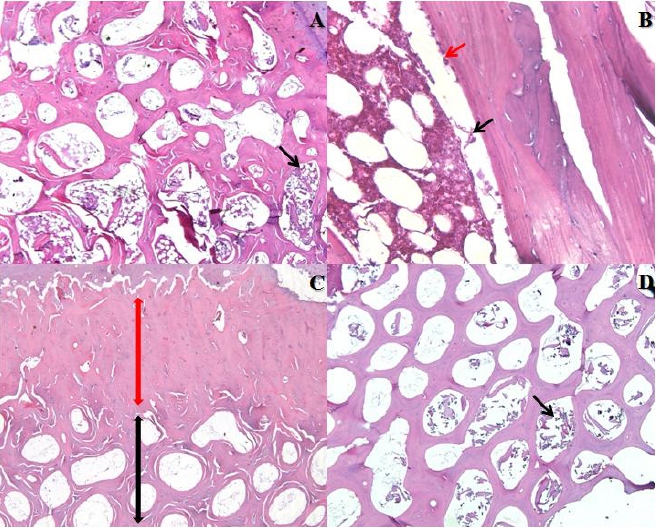
FIGURE 5 – Photomicrographies of the femoral head of ovines submitted to induction of osteonecrosis of the femoral head with ethanol and heterologous transplant of of mesenchymal bone-marrow cells from different sources. A . Arrow indicates presence of live bone marrow in the bone trabeculae. B. Zoom-in of the region shown in (A); black arrow points to cell of mesenchymal origin, red arrow to osteoblasts. C. Red arrow delineates region of the compact lamellar bone and black arrow the trabecular bone region in the control animal. D. Trabecular bone, arrow points to traces of live bone marrow. Magnifications of 4x (A, C, and D) and of 40X